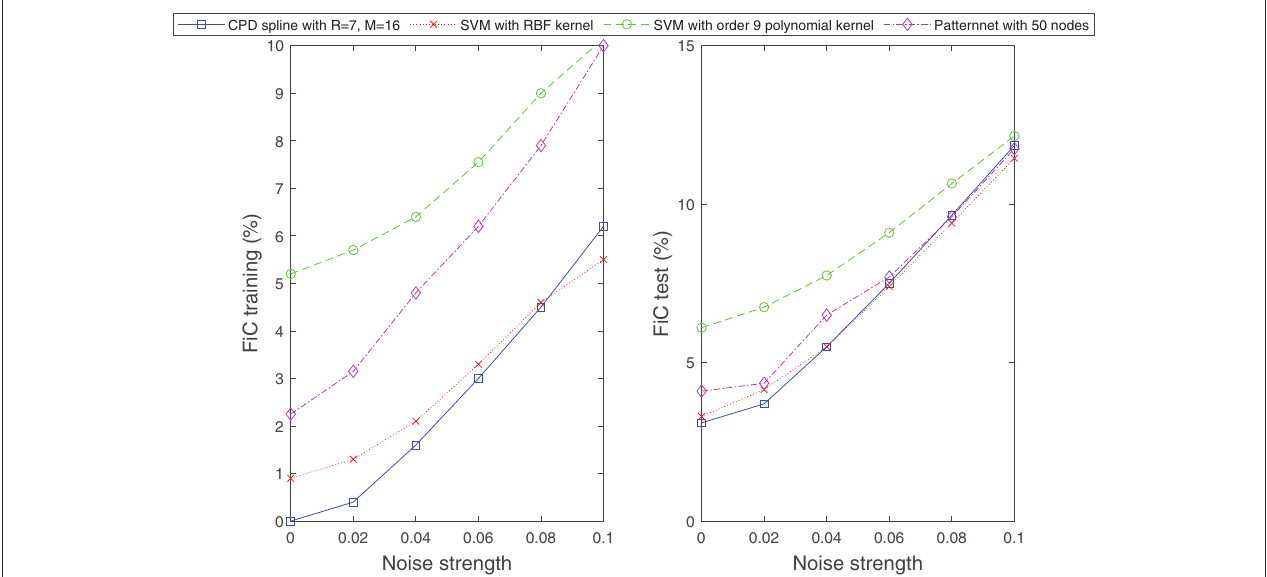
FIGURE 13 | Similar to well-established techniques for classification, the classifier (Equation 21) is capable of separating classification sets with ambiguous boundaries. Shown are the obtained results for the classification problem considered in Figure 11 , however, now the data samples are randomly perturbed by a vector of specific length (indicated by noise strength). The perturbation generates an ambiguous boundary between the two classes. The number of samples for the training and test dataset is set to 1000.